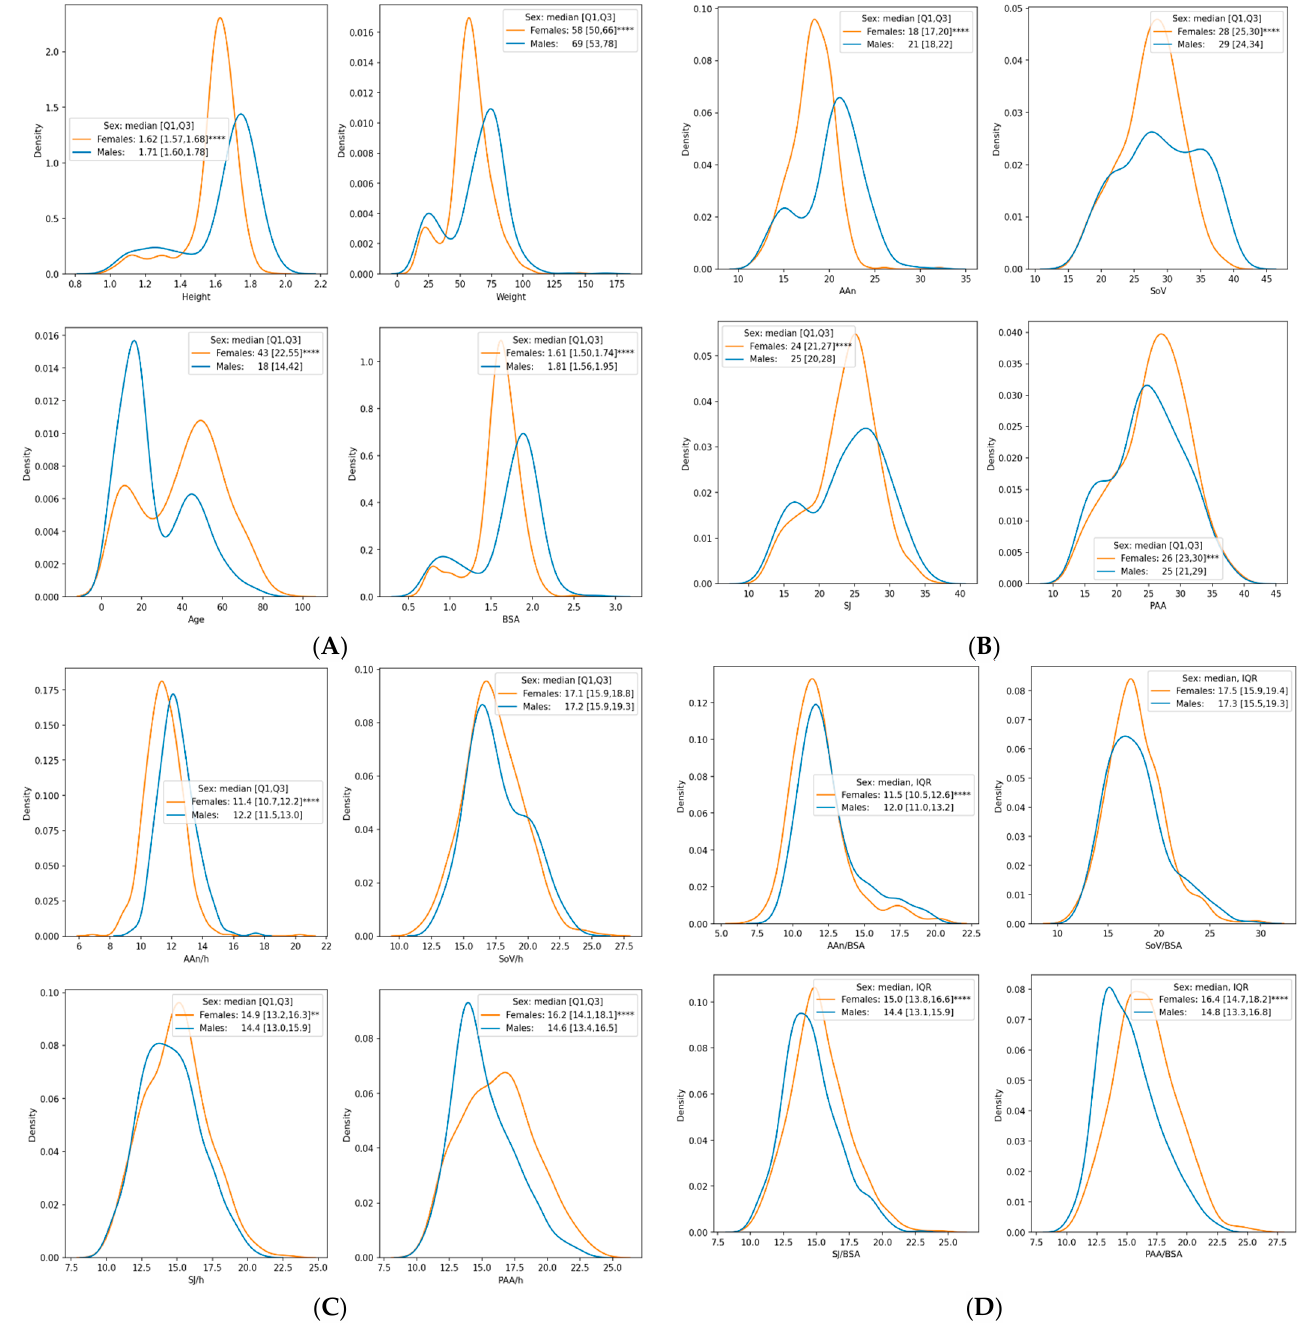
Figure 2. Kernel density estimates of demographics, anthropometrics and aortic sizes by sex. Distribution of height, weight, age and body surface area (BSA) are in ( A ). Distribution of aortic size at the annulus (AAn), sinuses of Valsalva (SoV), sino-tubular junction (SJ) and proximal ascending aorta (PAA), are reported as raw values ( B ) and after indexation for height (h; C ) and BSA ( D ). (**** p < 0.0001; *** p < 0.001; ** p < 0.01 (Kolmogorov–Smirnov two-sided test)). Table 1. Demographic and echocardiographic characteristics of the 1112 healthy subjects.